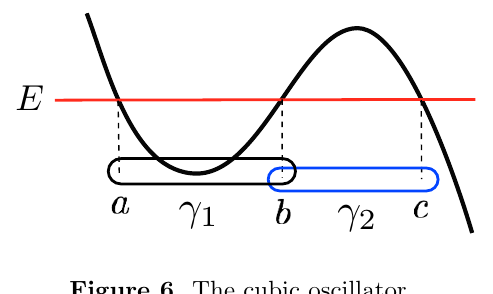
Figure 6 . The cubic